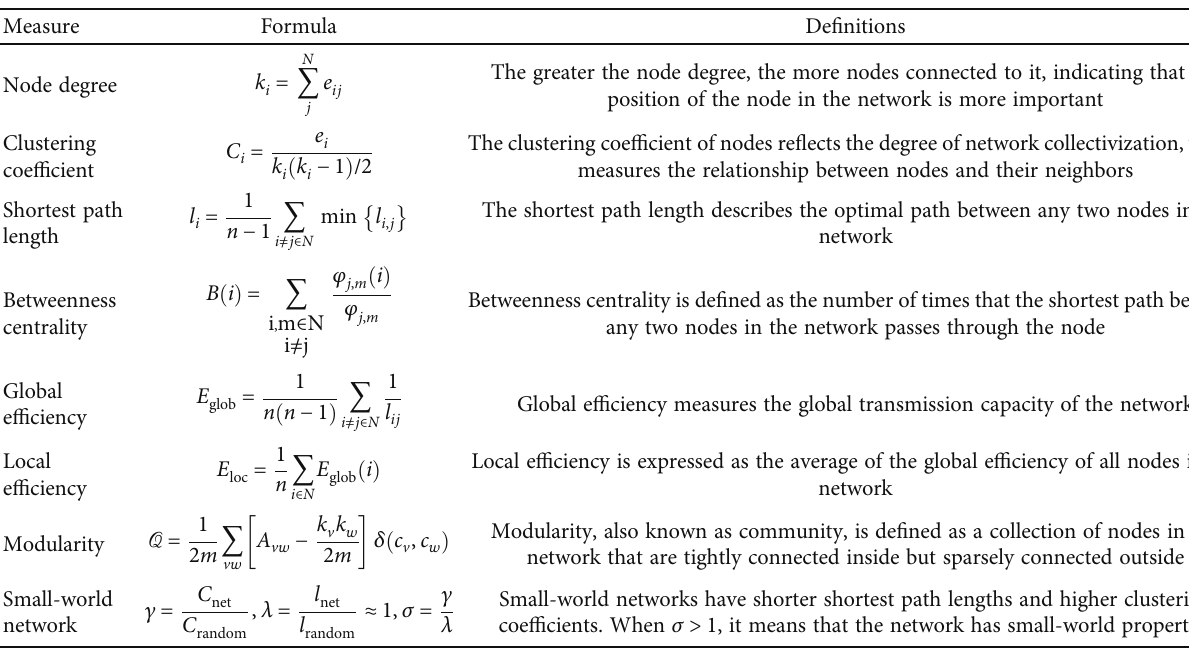
Table 2: Mathematical de fi nitions of complex network measures.